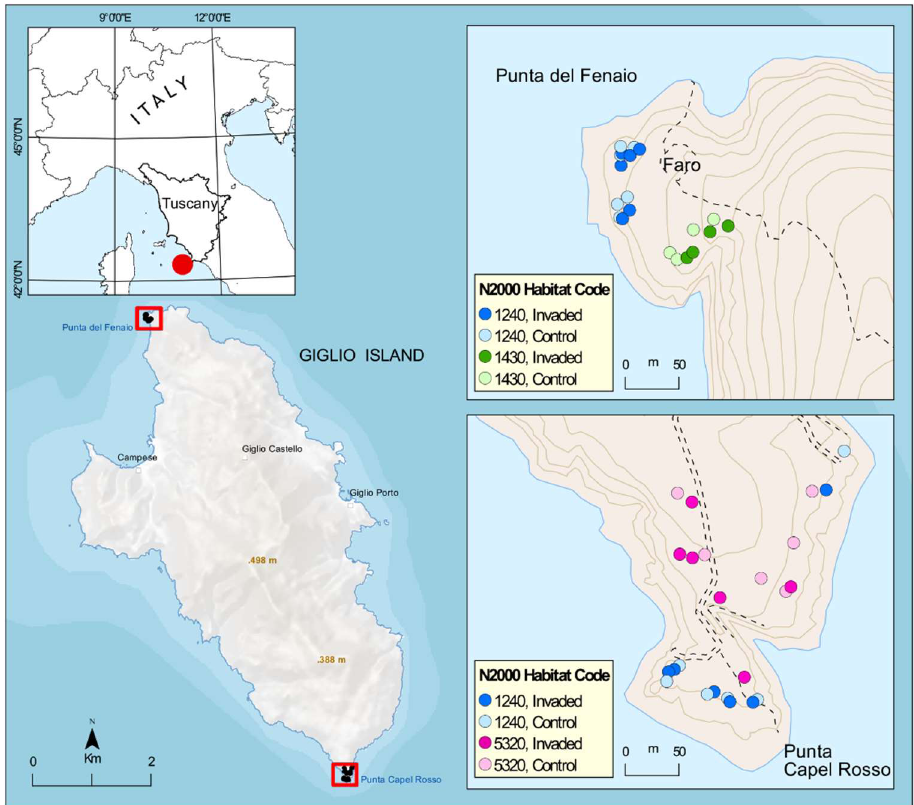
Figure 5. Area of study and distribution of the 44 sampling plots according to N2000 habitat and status of invasion. N2000 habitat codes: 1240 = vegetated sea cliffs of the Mediterranean coasts with endemic Limonium spp., 1430 = Halo-nitrophilous scrubs ( Pegano - Salsoletea ) and 5320 = Low formations of Euphorbia close to cliffs.